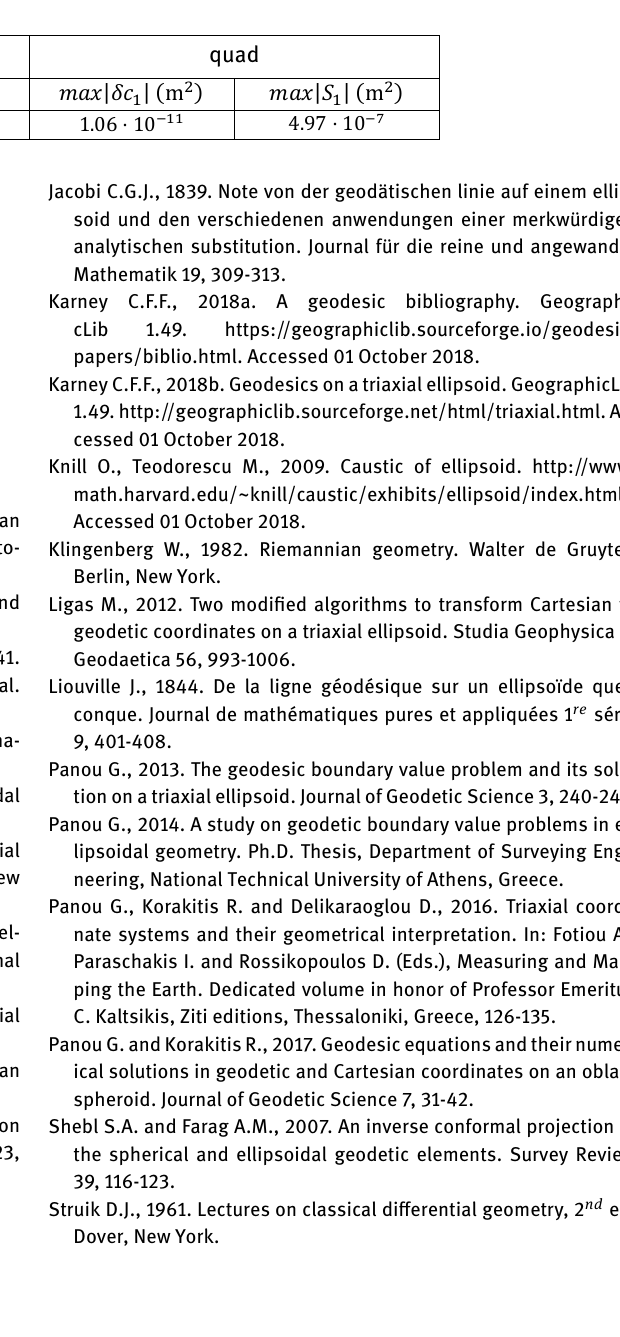
Table 14: Results in the Group